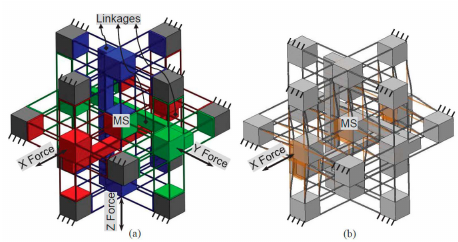
Figure 6. Final design of the XYZ CPM with three rigid linkages: ( a ) the final design and ( b ) the motion along the